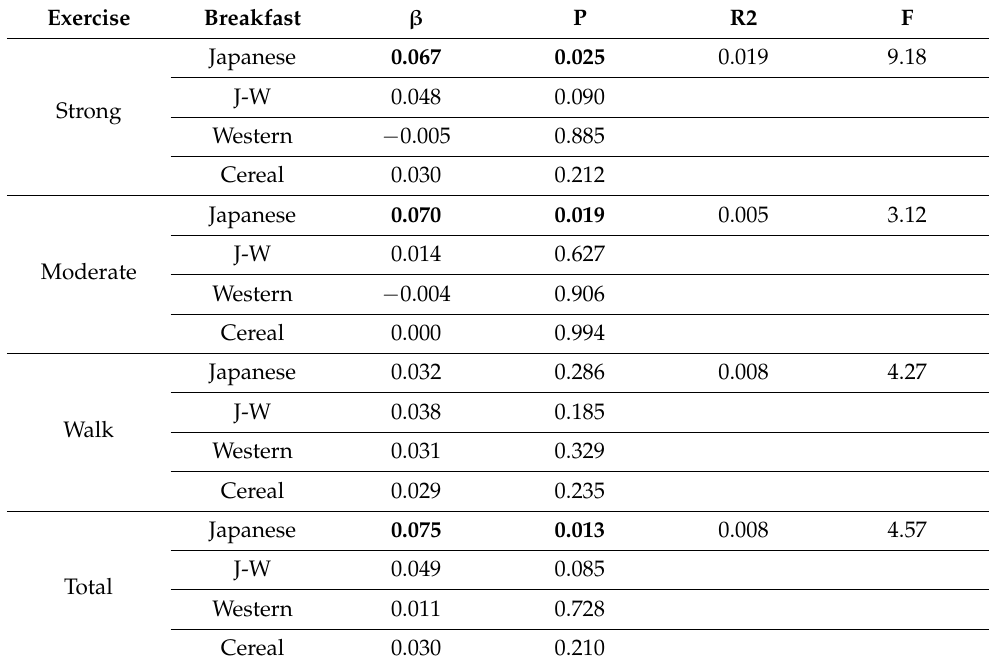
Table 3. Multivariate linear regression analysis for interaction between various exercise factors, sleep, and breakfast style.